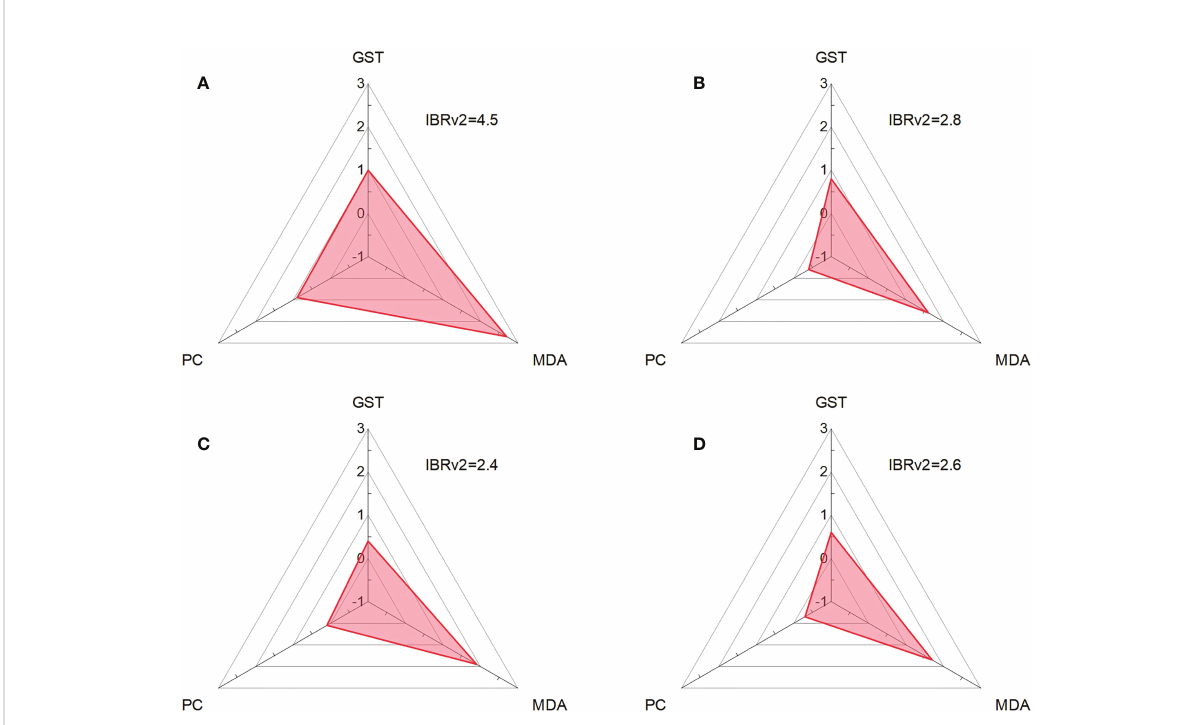
FIGURE 6 IBRv2 of red tilapia in the treatments of MPs (A) , l -HA+MPs (B) , m-HA+MPs (C) , and h-HA+MPs (D) after a 10-day